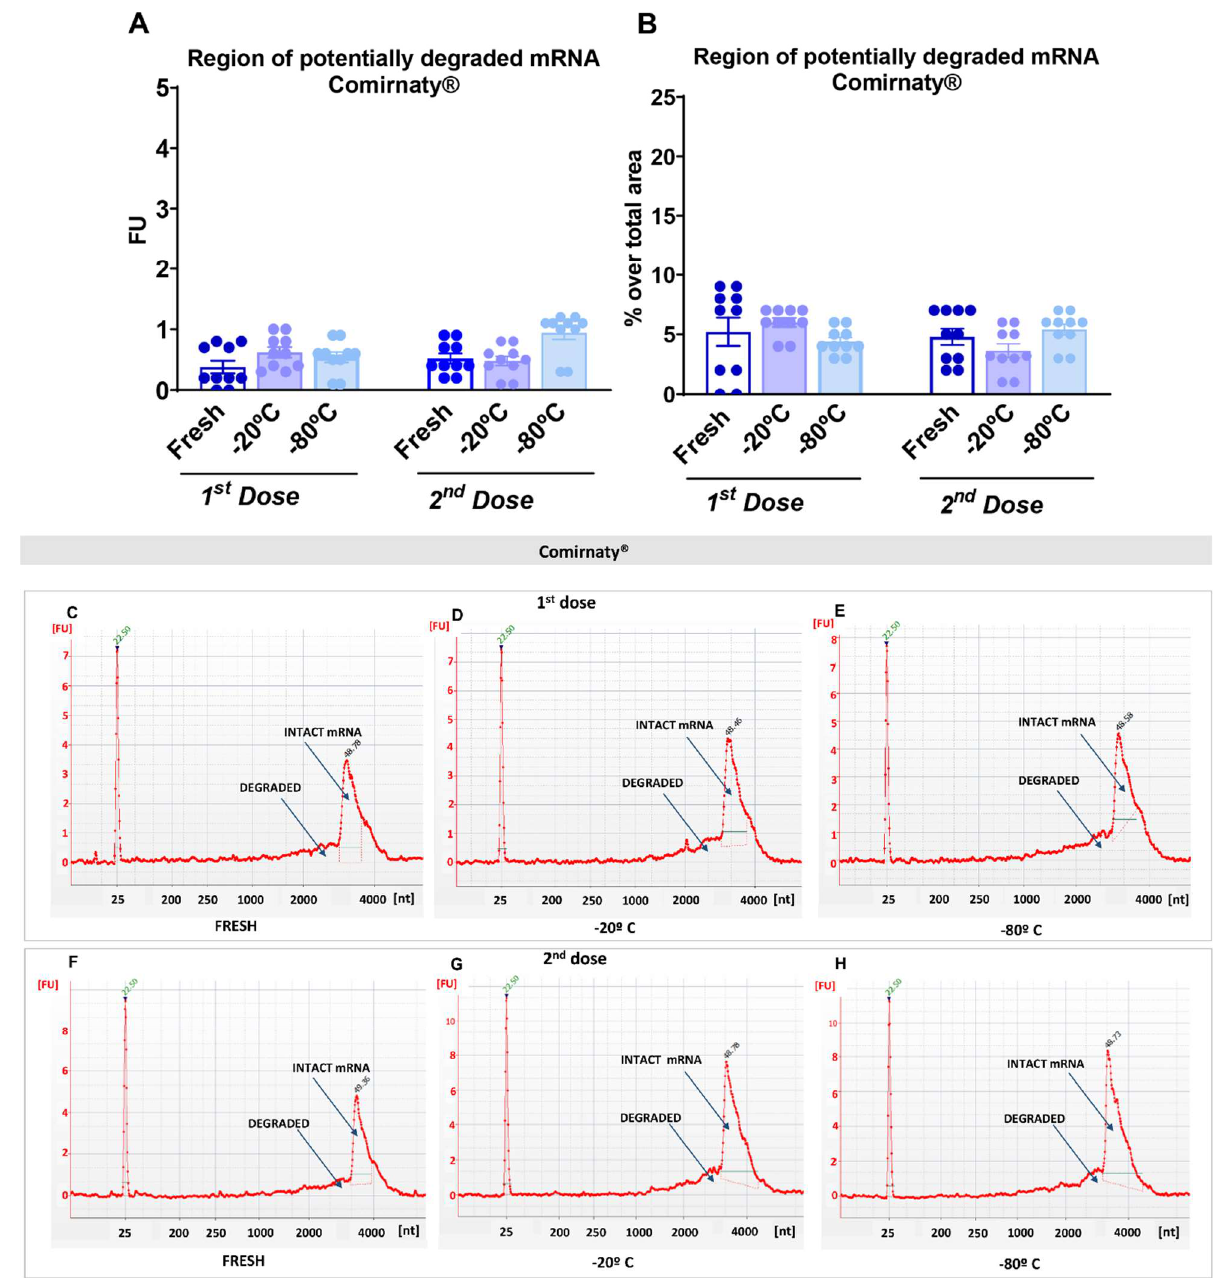
Figure 3. Different handling and re-freezing conditions did not affect mRNA integrity of reconstituted Comirnaty ® COVID 19 vaccines. ( A ) Measurement of the region of potentially degraded mRNA in fluorescence units (FUs) of the regularly used (fresh) samples or under −20 °C or −80 °C storage conditions in the first and second doses. Individual values of FU with the mean ± SEM are represented. ( B ) Percentage over the region’s total area of potentially degraded mRNA of the samples regularly used (fresh), or under −20 °C or −80 °C storage conditions in the first and second doses. Individual values of FU percentage with the mean ± SEM are represented ( n = 10 per group). ( C – H ) Representative electropherograms expressed in FU of RNA integrity for different mRNA samples detailing the regions that indicate potentially degraded and intact mRNA peaks in the regularly used (fresh) samples or under −20 °C or −80 °C storage conditions in the first and second doses. Statistical details are included in Table S1.